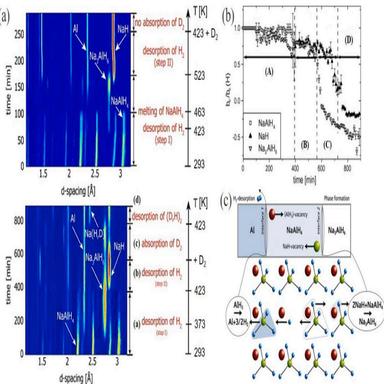
(a) Neutron diffraction patterns of uncatalysed (top) and TiCl3-catalysed (bottom) NaAlH4 versus desorption time during hydrogen desorption; (b) Variation of the effective coherent scattering length bc at the hydrogen sites normalized to bc(H) for NaAlH4, Na3AlH6 and NaH, respectively, over time for the TiCl3-catalysed sample. The formation of hydrogen vacancy results in a decreased in bc/bc(H) in the time intervals (A) and (B), while hydrogen–deuterium exchange leads to more significant reductions in the t